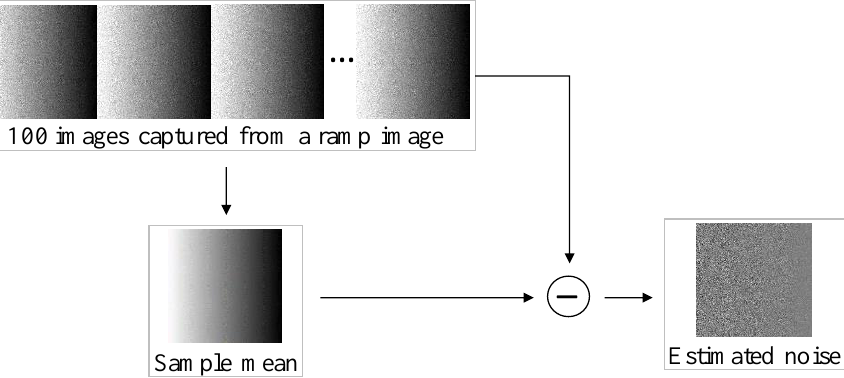
Figure 3. Example of noise estimation using sample mean.